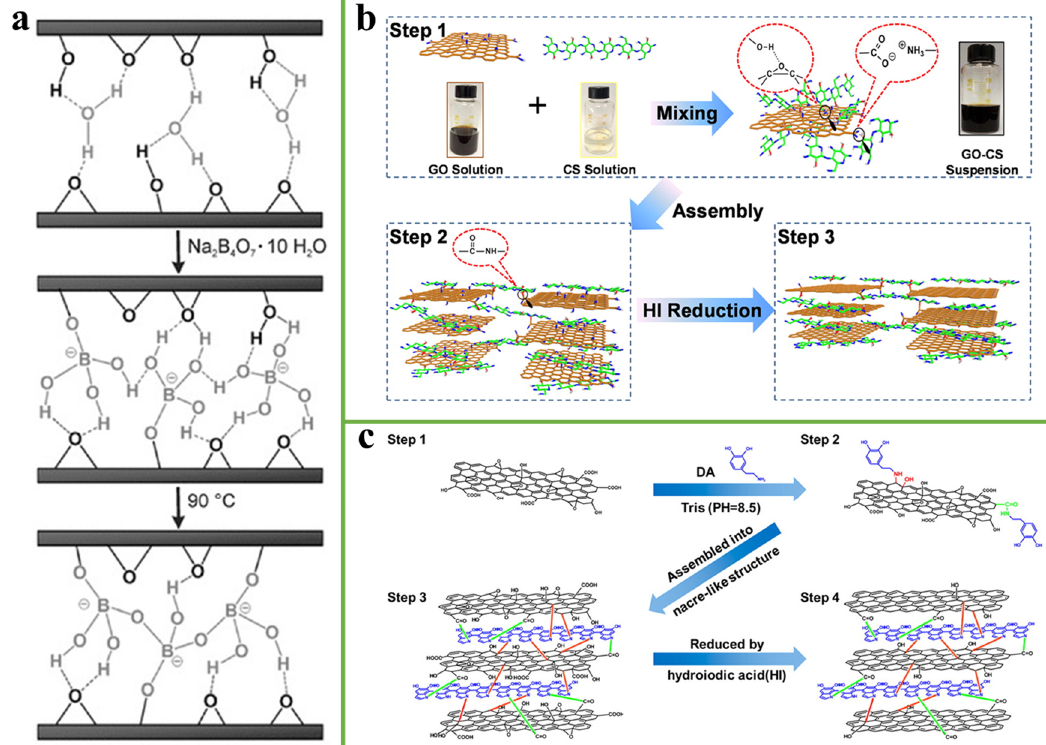
Figure 9. ( a ) Schematic illustration of the formation of the borate-crosslinked network across two adjacent graphene oxide nanosheets. Reprinted with permission from ref. [81] Copyright 2011, Wiley. ( b ) Illustration of the manufacturing process of rGO-CS artificial nacres. Reprinted with permission from ref. [84] Copyright 2015, American Chemical Society. ( c ) Structural model for dopamine cross-linked graphene oxide film. Reprinted with permission from ref. [86] Copyright 2014, American Chemical Society.